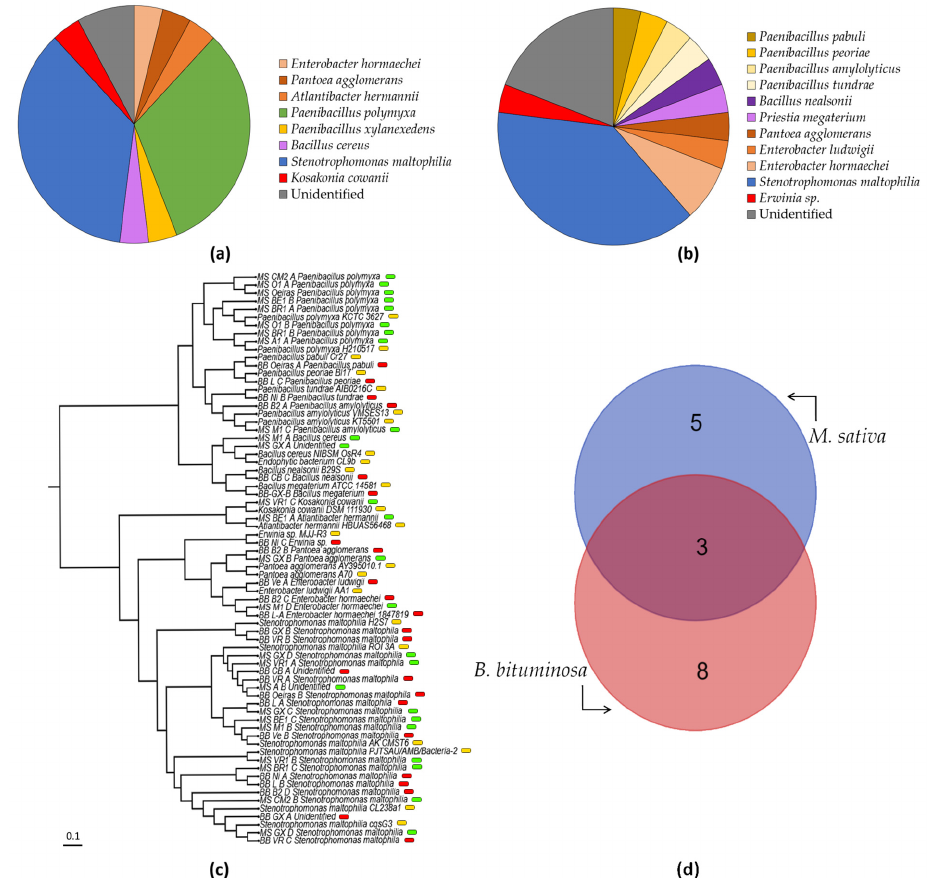
Figure 4. Prevalence of strains isolated from Medicago sativa and Bituminaria bituminosa seeds. The pie charts show the proportion of each strain isolated by sample location in ( a ) Medicago sativa and ( b ) Bituminaria bituminosa seeds. Colors of each section stand for Stenotrophomonas maltophilia (blue), Paenibacillus polymyxa (green), other Paenibacillus strains (yellow), Enterobacteriaceae strains (orange), Bacillaceae strains (purple), putative pathogens Erwinia sp. and Kosakonia cowanii (red), and unidentified strains (grey). The phylogenetic tree ( c ) shows the related species used to identify our collection, where green labels stand for M. sativa strains; red, for B. bituminosa ; and yellow, for the control strains determined by BLAST for identified strains. The Venn diagram ( d ) shows the number of species isolated from M. sativa and B. bituminosa seeds, and their overlapping.